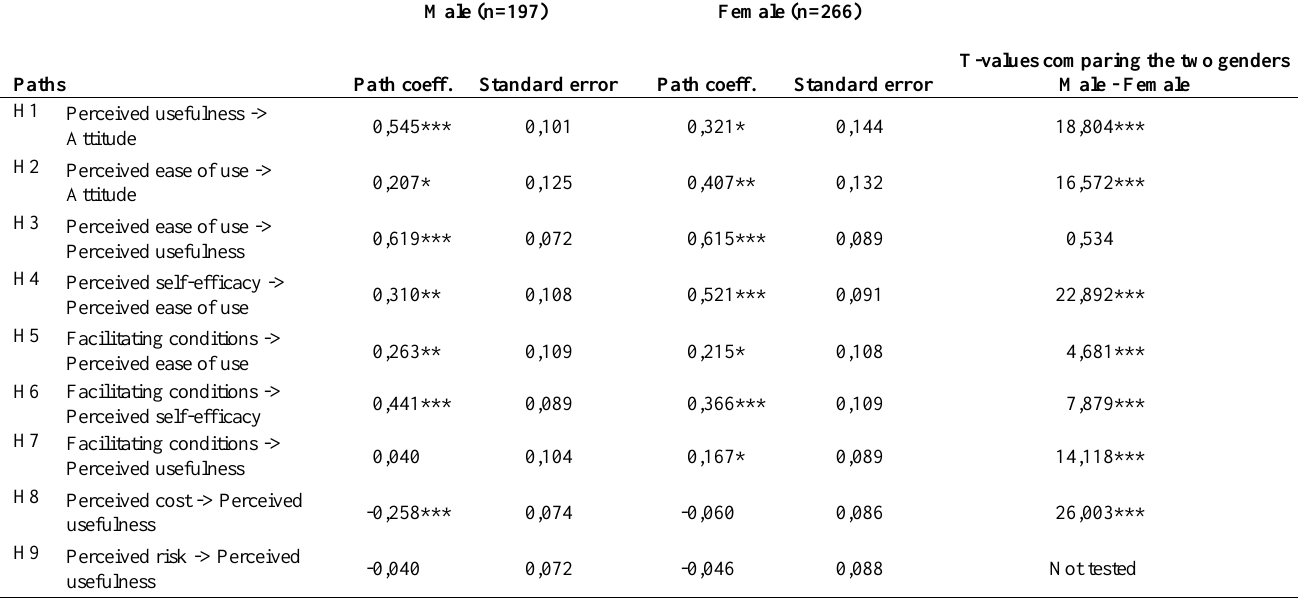
Male (n=197) Female (n=266)